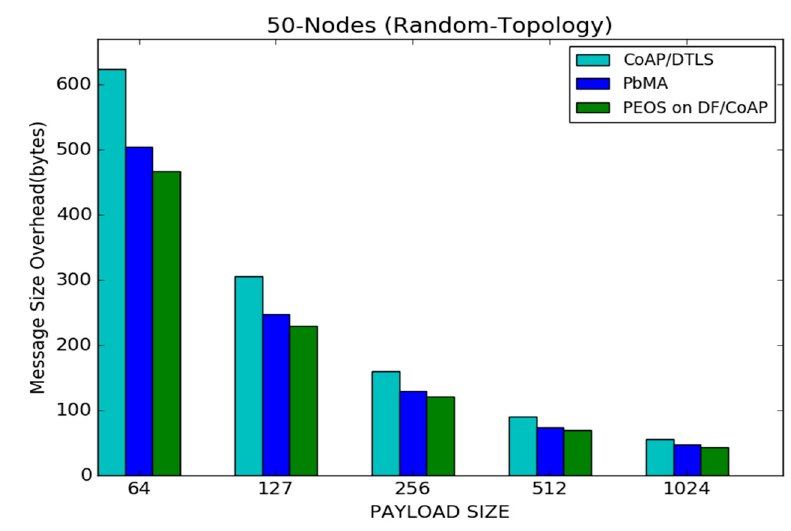
Figure 14. Payload size vs. message size overhead for 50 node topology.